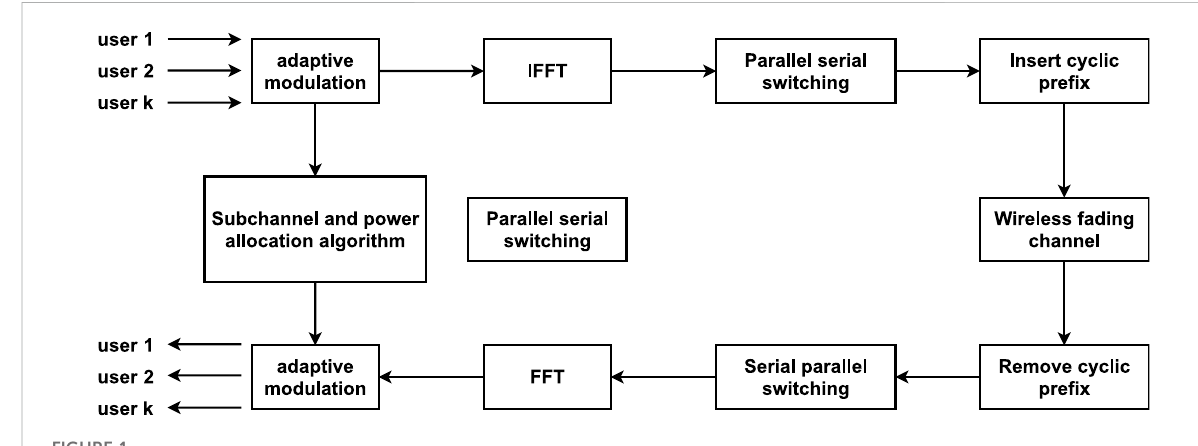
FIGURE 1 Resource allocation principle of wireless network communication system.